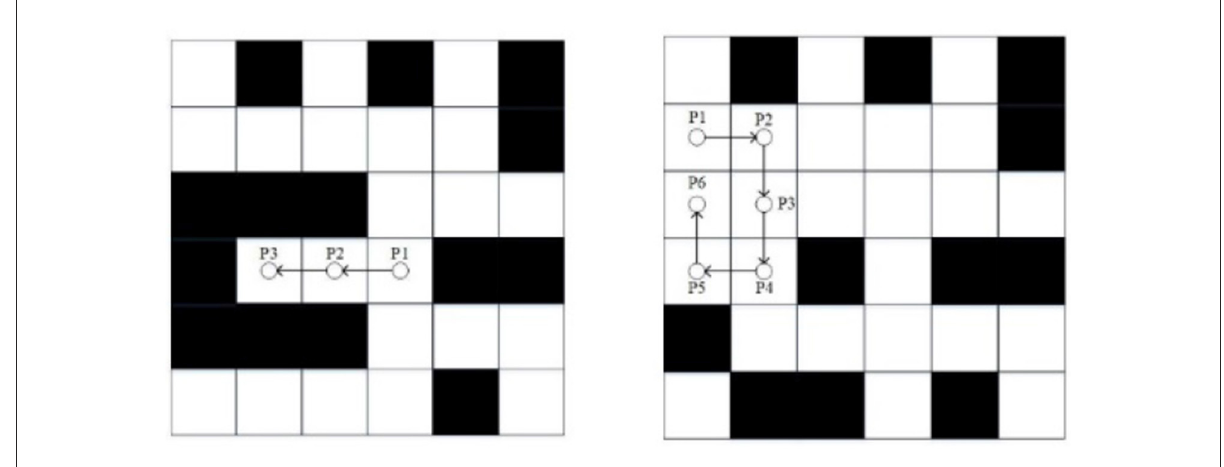
FIGURE4 Deadlock and self-locking.